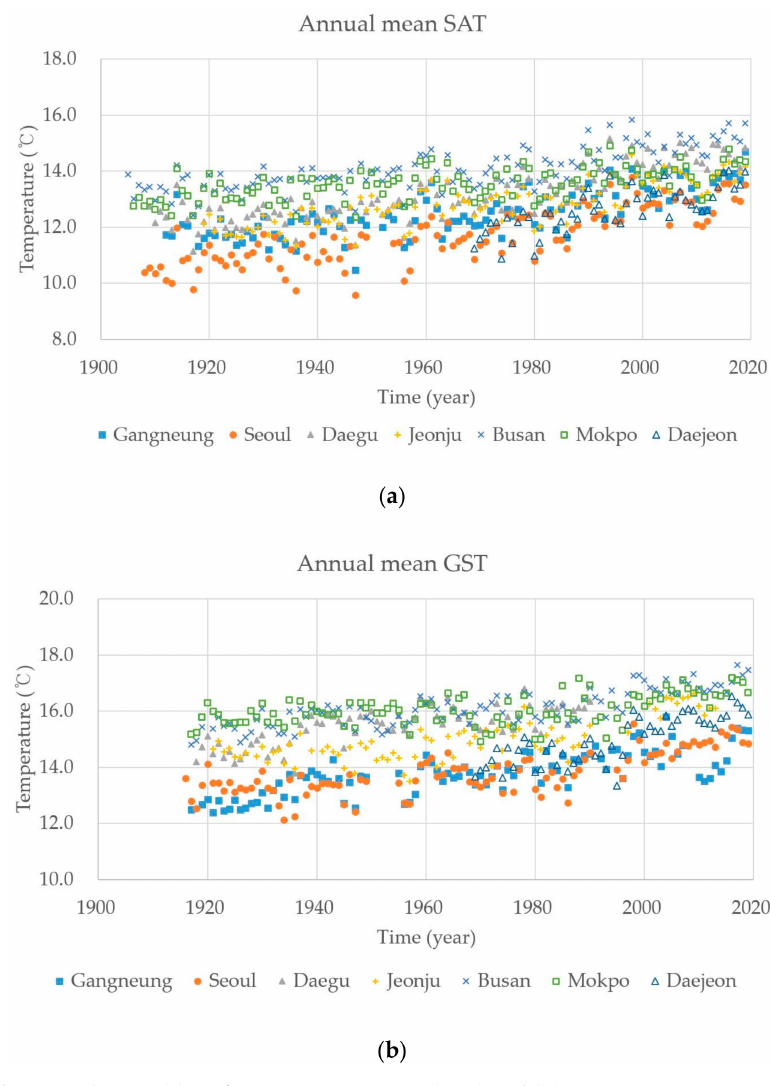
Figure 4. The annual mean ( a ) surface air temperatures (SAT) and ( b ) GST in Gangneung, Seoul, Daegu, Jeonju, Busan, Mokpo, and Daejeon observed by the Korea Meteorological Administration. The SATs in Gangneung, Seoul, Daegu, Jeonju, Busan, Mokpo, and Daejeon have been measured since 1912, 1907, 1909, 1919, 1904, 1906, and 1969, respectively. The GSTs in Gangneung, Seoul, Daegu, Jeonju, Busan, Mokpo, and Daejeon have been measured since 1917, 1916, 1918, 1921, 1917, 1917, and 1969,